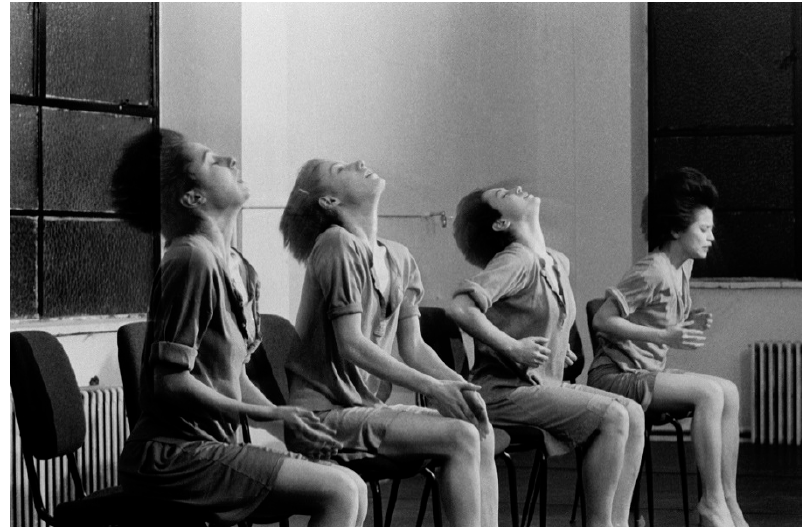
Figure 1. Rosas danst Rosas (1983) Anne Teresa De Keersmaeker/Rosas @ Jean-Luc Tanghe. Used with Rosas danst Rosas (1983) Anne Teresa De Keersmaeker / Rosas © Jean-Luc permission.